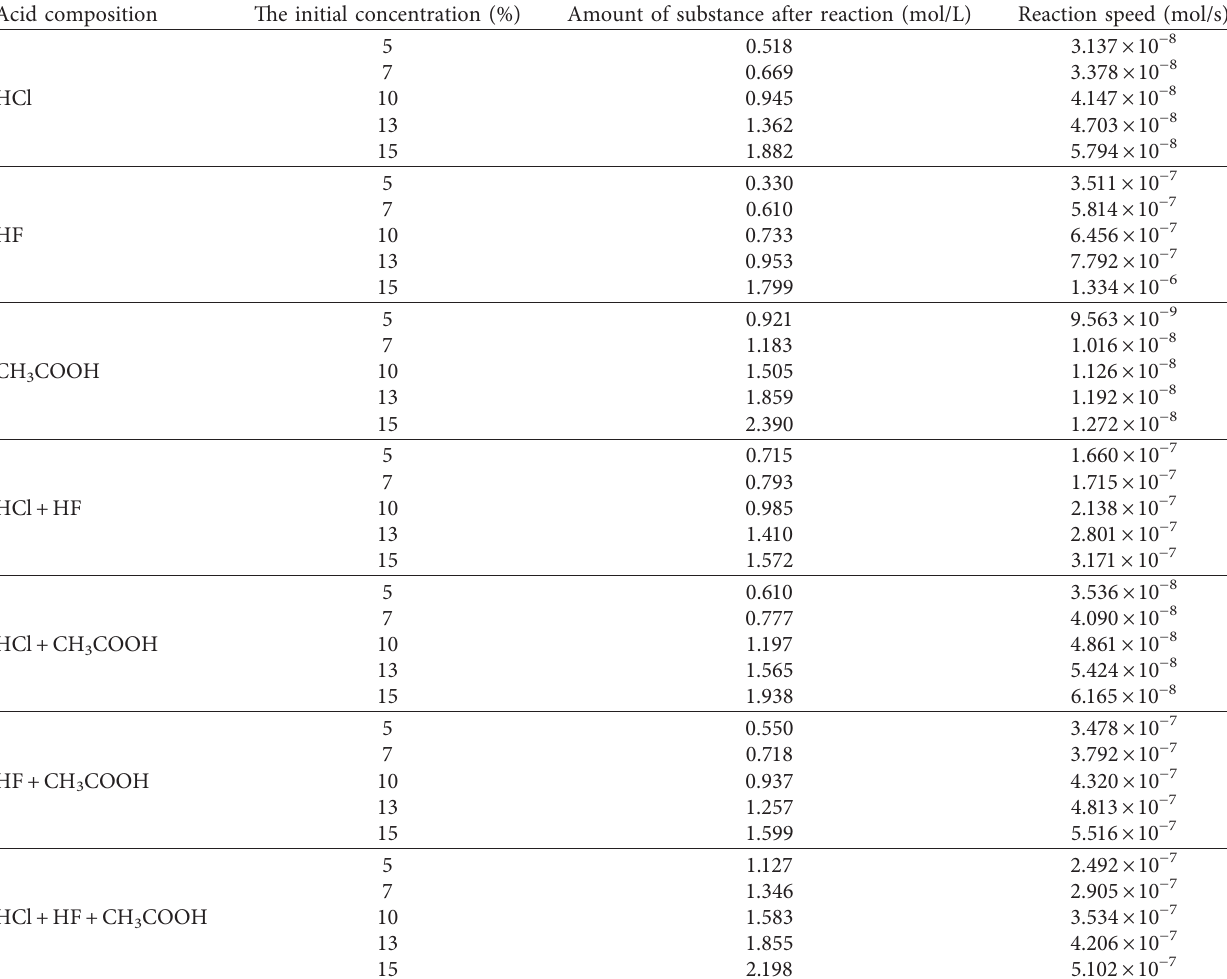
Table 1: Statistics of experimental data on the reaction of different types of acids with sodium bentonite. Acid